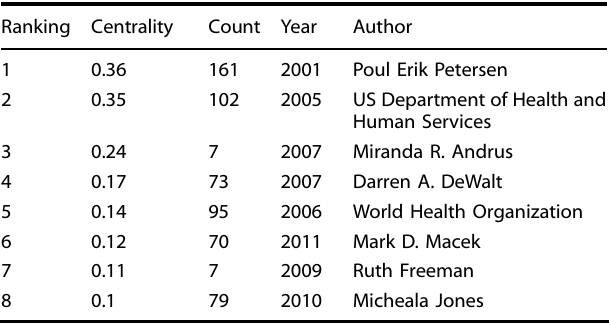
Table 3. Co-cited authors according to a centrality >